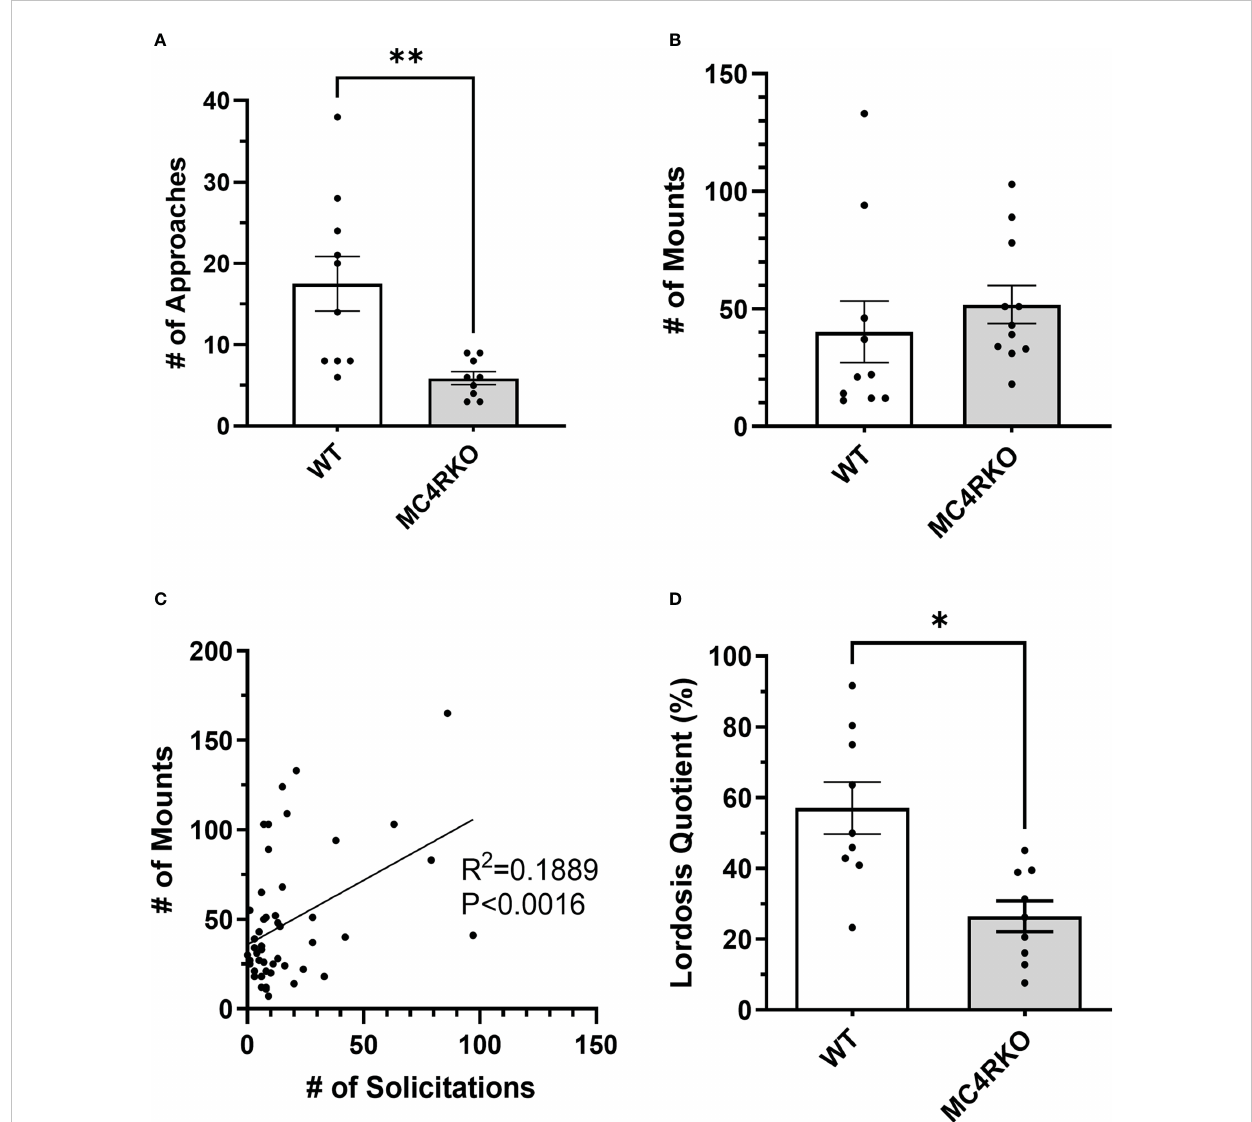
FIGURE 5 MC4R deletion resulted in fewer approach behaviors and a lower lordosis quotient compared to the WT control. Female approaches towards the male (sniffs or touches) (A) , Male mounts (B) , and lordosis quotient (D) are compared between WT (n=9) and MC4RKO (n=9-11). All mouse groups were combined (WT, Sim1-cre, Oxt-cre, MC4RKO, tbMC4R Sim1 , tbMC4R Oxt ; n=50) to run correlation analysis on approaches vs mounts (C) . Groups in this fi gure were statistically analyzed together with groups from Figure 6. One-way ANOVA with Sidak ’ s multiple comparisons test was used for graphs A and C. Brown-Forsythe and Welch ANOVA tests with Dunnett ’ s T3 multiple comparisons test was used for graph B. Graph A, p=0.008. Graph B, p=0.018 *p<0.05;